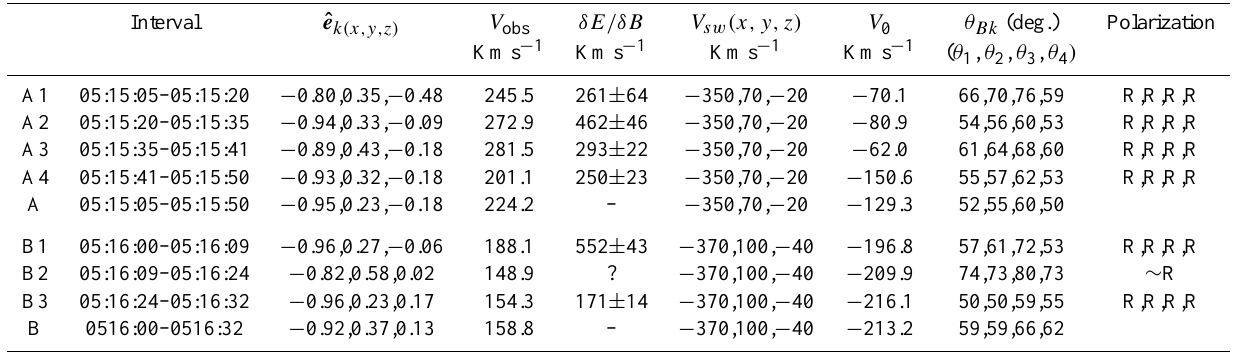
Table 1. Observed polarization senses are the results at four spacecraft, respectively.